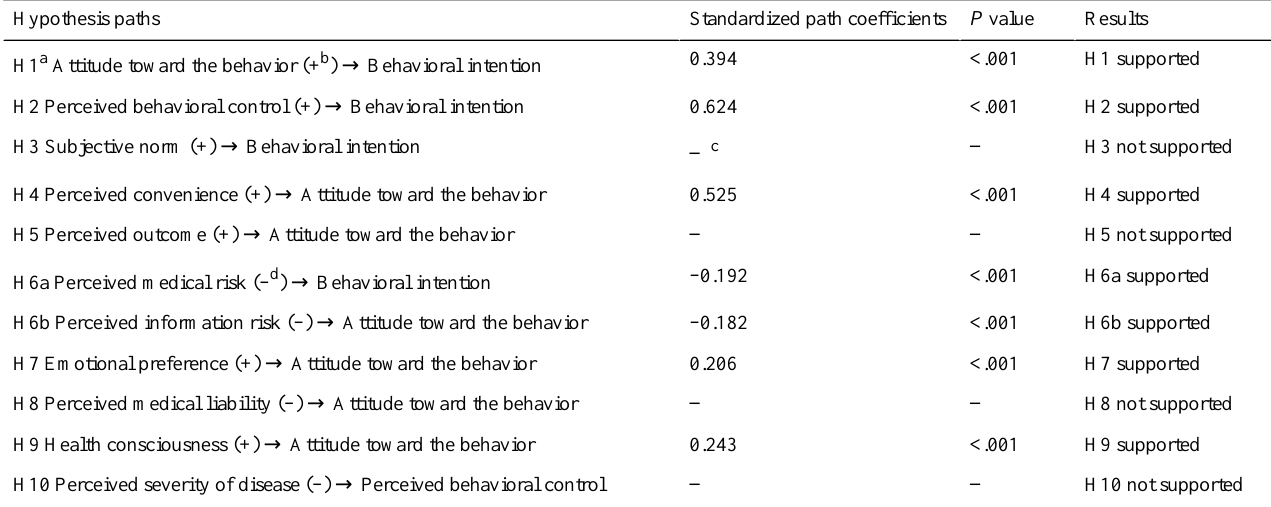
Table 5. Hypothesis testing results of the research